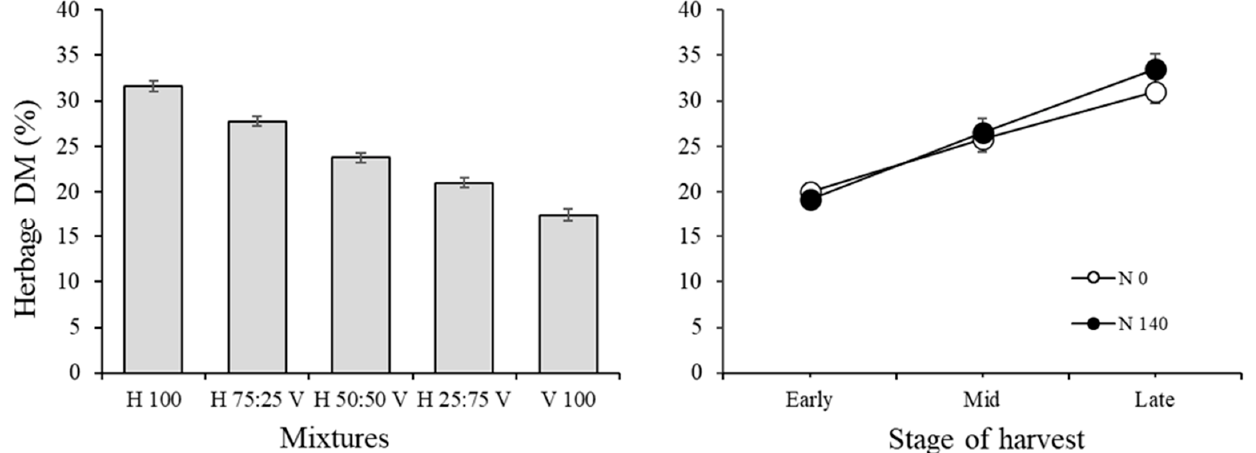
Figure 1. Herbage DM concentration as affected by MX mean effect ( left ) and SH × NF interaction ( right ). On the left, values are LSmeans across all treatments along with standard error estimate of the LSmeans since the design was unbalanced between the faba bean crop ( n = 9) compared to the mixtures and the barley crops ( n = 18). On the right, only data of the barley-containing treatments were used. Each point represents the arithmetic mean ( n = 24) and its computed standard error.